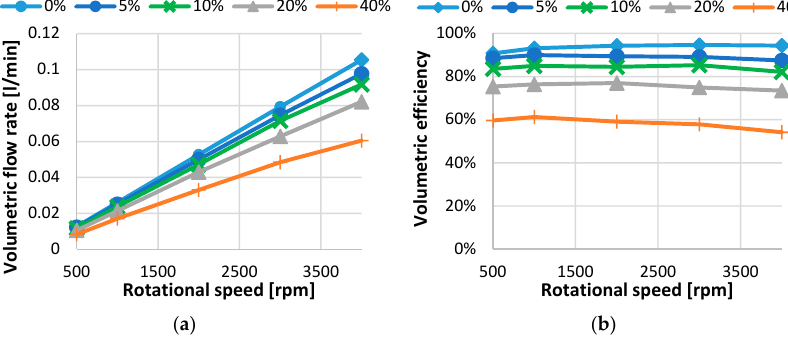
Figure 25. ( a ) Volumetric flow rates and ( b ) the respective volumetric efficiencies for different IGVF of free air and rotational speeds at 5-bar delivery pressure.